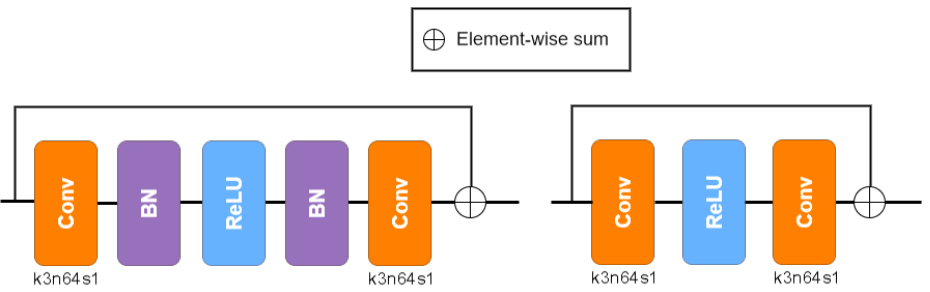
Figure 1. Comparison between the residual blocks in SRResNet ( left ) and in EDSR ( right ). The Batch Normalization layers from the left have been removed to create the residual blocks of EDSR ( right